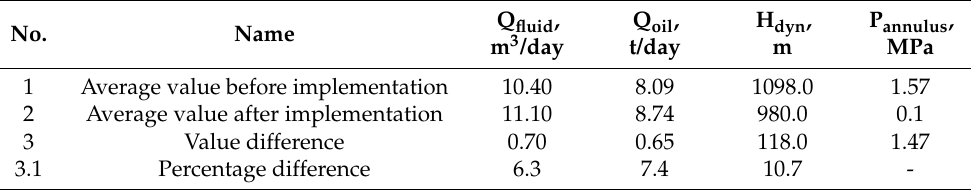
Table 2. Well parameters before and during implementation of